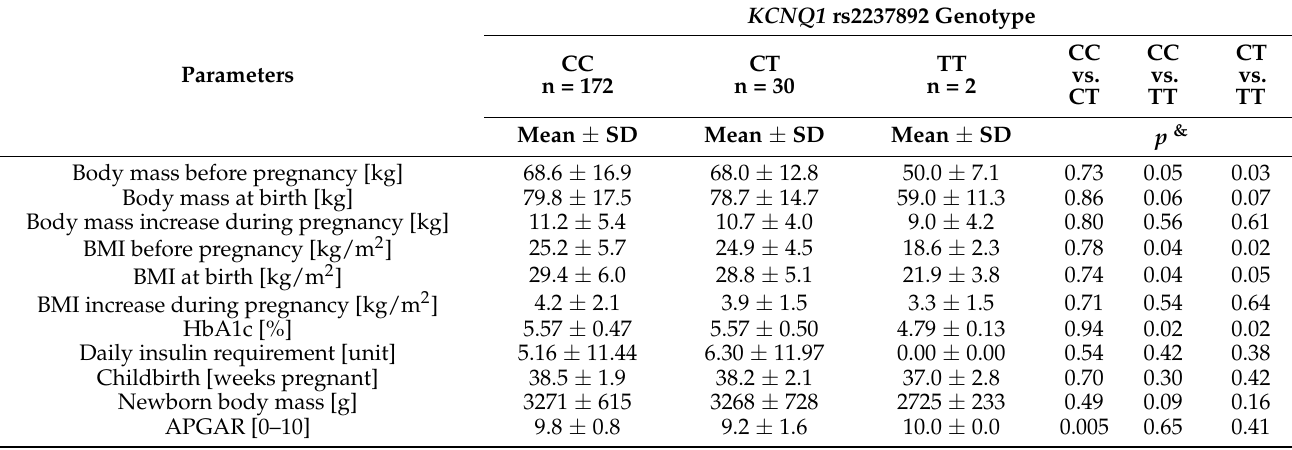
Table 7. Clinical parameters of women with GDM stratified according to KCNQ1 rs2237892